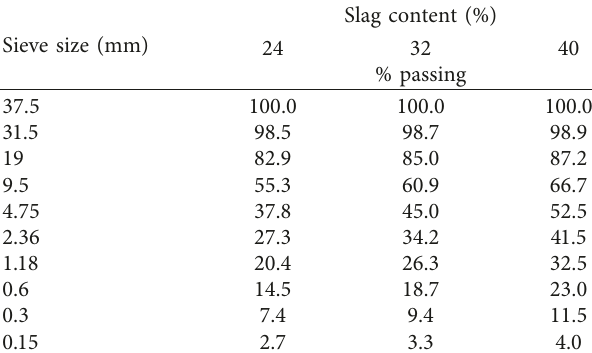
Table 5: Aggregate gradation of